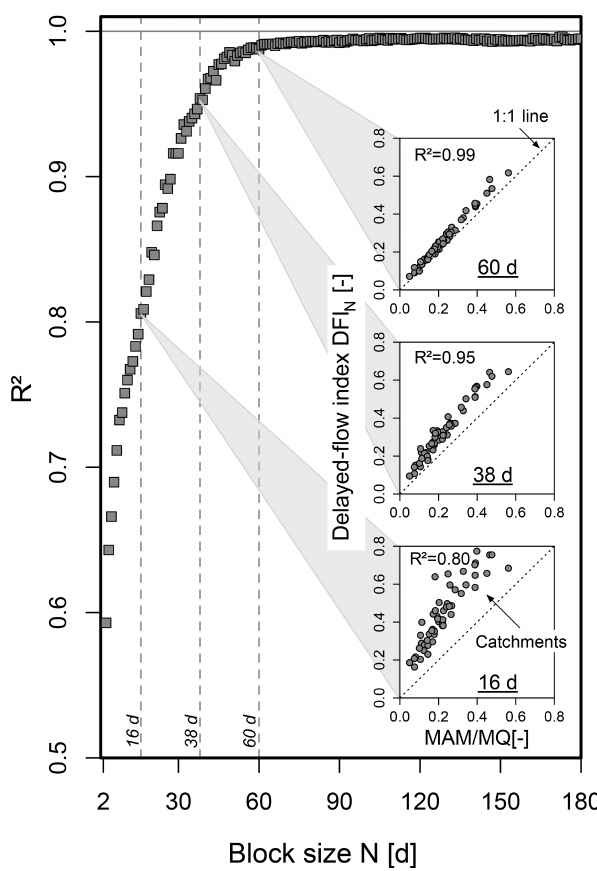
Figure 2. The coefficient of determination R 2 between DFI N and the ratio of the mean annual minimum flow to mean flow (MAM/MQ) for varying block size N values ranging between 2 and 180d. Insets show the degree of agreement (as compared to a 1 : 1 line) for three exemplary block sizes, N = 16, 38,